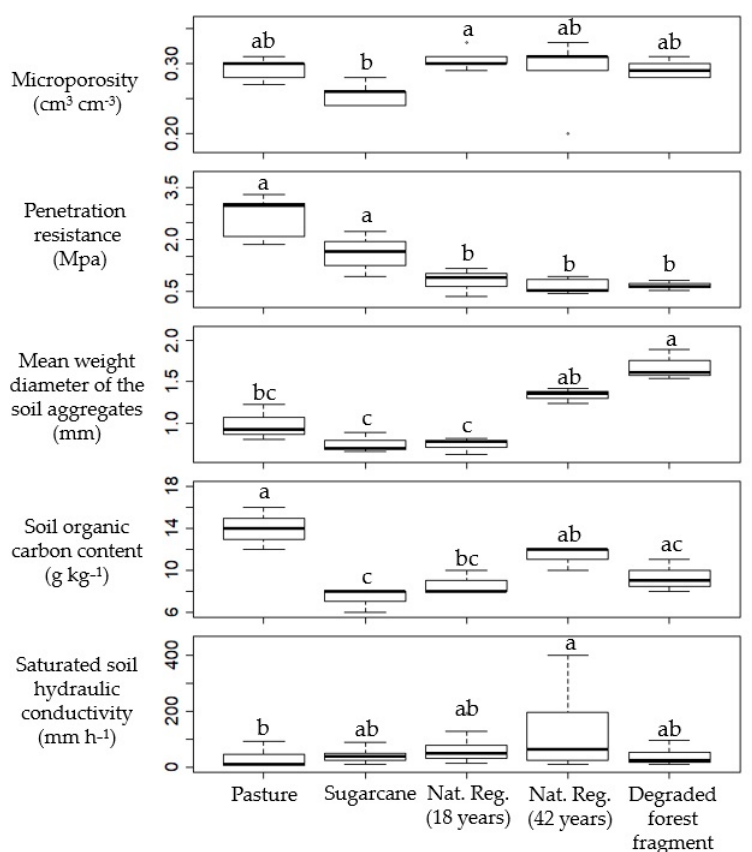
Figure 3. Boxplot of hydrophysical attributes for the different land uses. Line within the box is the median. The bars represent standard error. Note: For this figure, we only considered the soil physical attributes that presented significant differences, according to Table 2. Nat.Reg = natural regeneration.